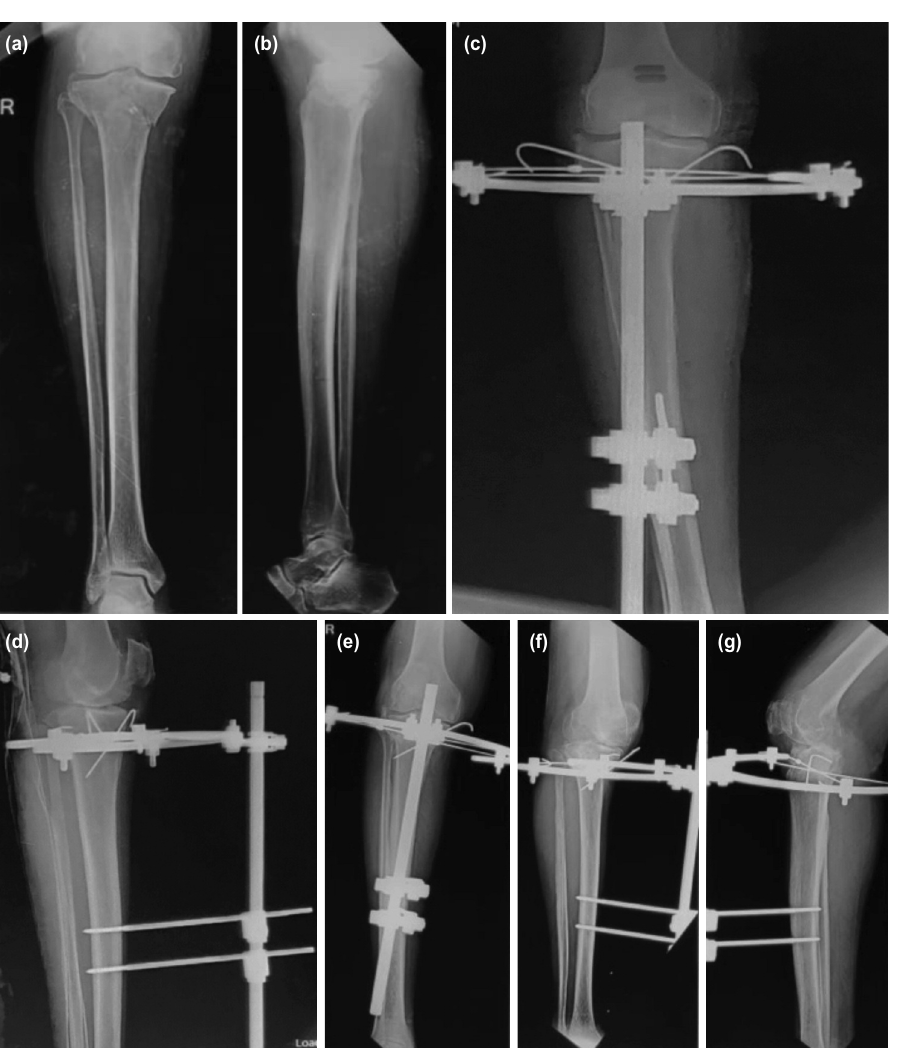
(a,b) Showing the pre-operative radiograph. (c) Showing the immediate post-operative radiograph AP view. (d) Showing the Fig. 1: immediate post-operative lateral radiograph. (e,f,g) Showing complete union at the fracture site at three months follow-up.